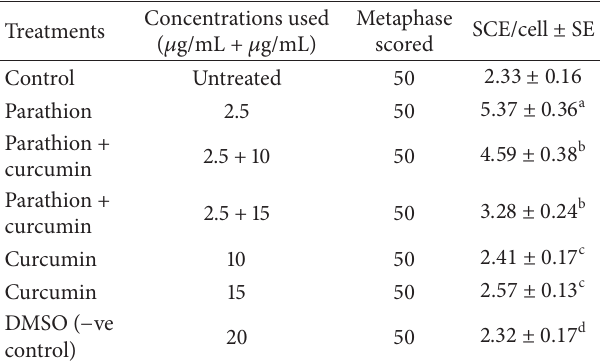
Table 2: Antigenotoxic effect of curcumin against parathion treated cultured human lymphocytes.